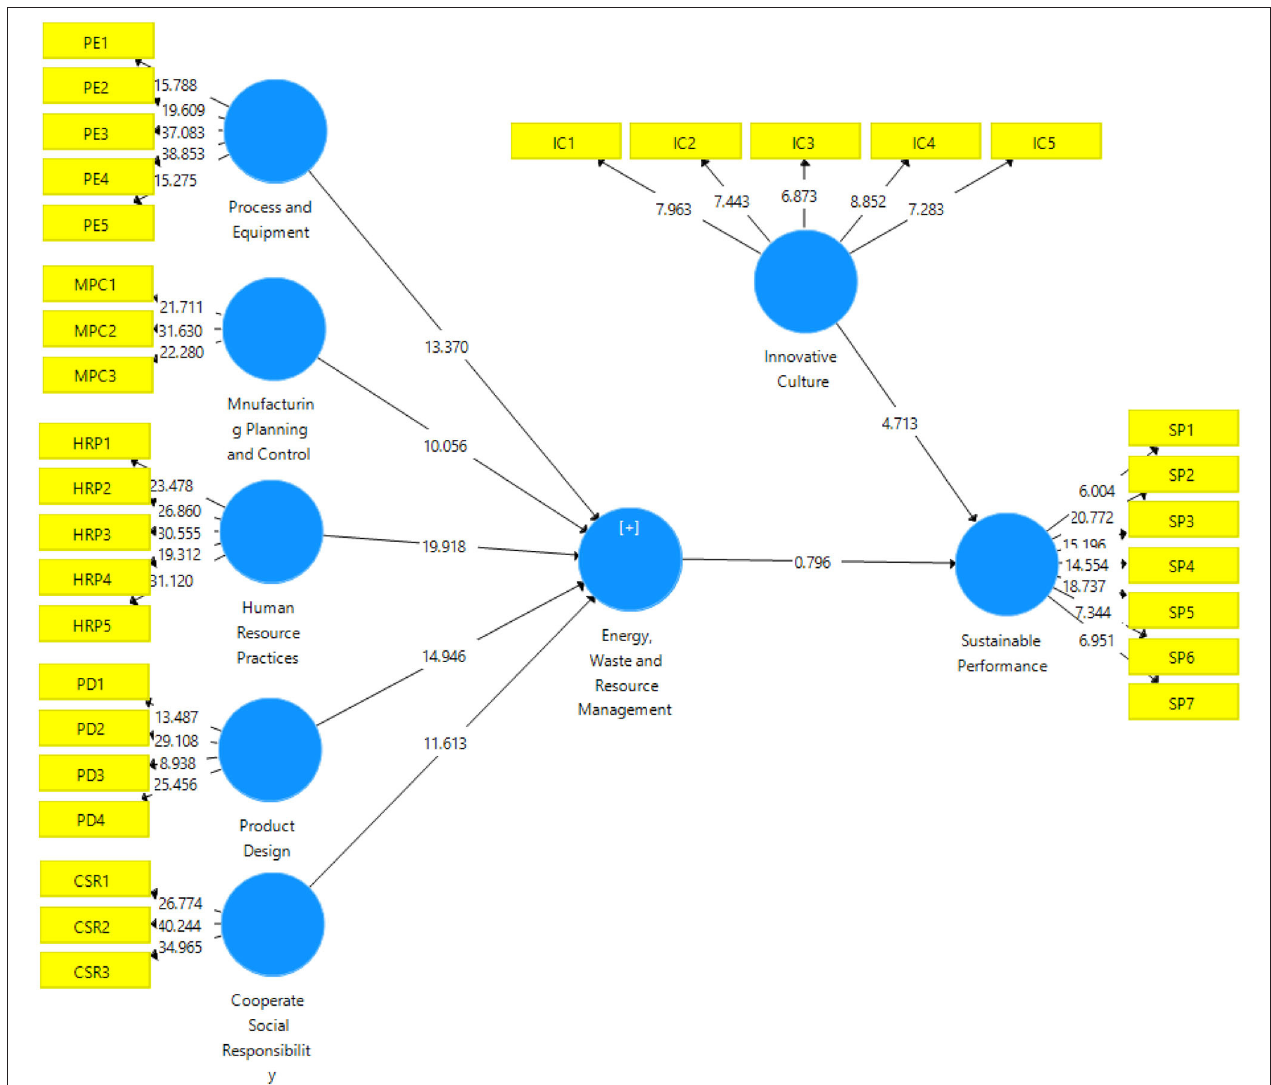
FIGURE 2 | Output of measurement model